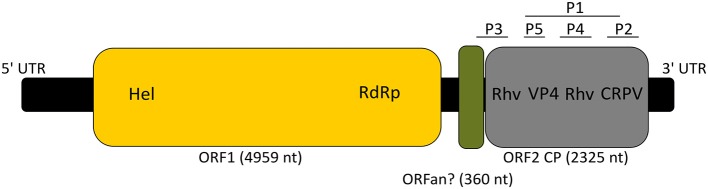
Schematic genome organization of GdRNAV-01 (9,233 nt). 5′UTR: 5′ untranslated region (1,008 nt), 3′ UTR: 3′ untranslated region (367 nt). The yellow box indicates the replication polyprotein with Hel: Helicase and RdRp: RNA-dependent RNA polymerase. The gray box represents the capsid proteins (CP) with domains corresponding to the Rhv_like superfamily interspaced by the Dicistro_VP4, and the CRPV_capsid superfamily. The green box indicates the possible ORFan. P1 to P5: structural proteins. Segments corresponding to P1 to P5 are not scaled on the genome sequence.